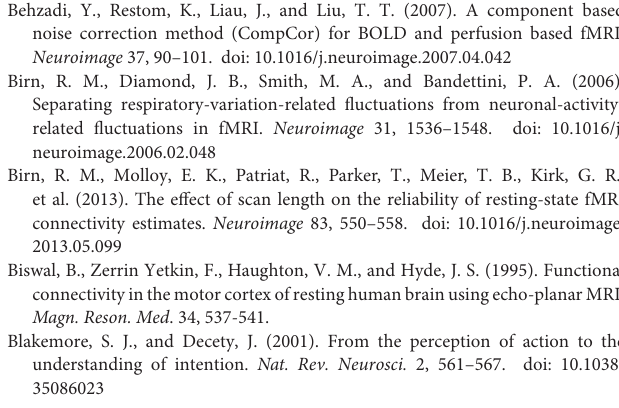
FIGURE S1 | Group-level functional connectivity of the beta-value in the default mode network during resting-state, and in response to ASMR effects. Functional connectivity of the posterior cingulate cortex seed region in response to (A) ASMR, and (B) resting-state. Functional connectivity of the medial prefrontal cortex seed region in response to (C) ASMR, and (D) resting-state. Functional connectivity of the left lateral parietal cortex seed region in response to (E) ASMR, and (F) resting-state. Functional connectivity of the right lateral parietal cortex seed region in response to (G) ASMR, and (H) resting-state. FIGURE S2 | Group-level functional connectivity of the beta-value in the affective touch, self-, and other-networks during resting-state, and in response to ASMR effects. Functional connectivity of the right posterior insular cortex seed region in response to (A) ASMR, and (B) resting-state. Functional connectivity of the pregenual anterior cingulate cortex seed region (C) in response to ASMR, and (D) resting-state. Functional connectivity of the posterior cingulate cortex/precuneus seed region in response to (E) ASMR, and (F) resting-state. FIGURE S3 | Group-level functional connectivity of the beta-value for ASMR > resting-state contrast. Default mode networks with seed regions of (A) the posterior cingulate cortex, (B) medial prefrontal cortex, (C) left lateral parietal cortex, and (D) right lateral parietal cortex. (E) Self-network with the pregenual anterior cingulate cortex seed region. (F) Other-network with the posterior cingulate cortex/precuneus seed region. (G) Affective touch network with the posterior insular cortex seed